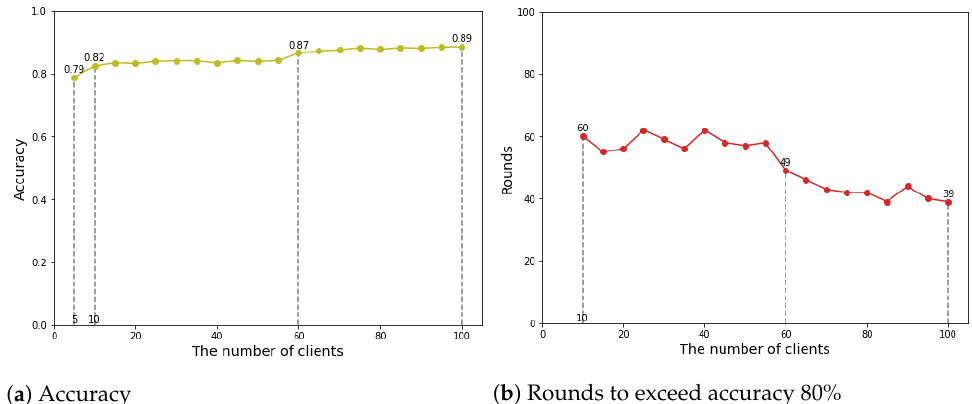
Figure 9. Accuracy of FLIC under the different number of clients participating in training.